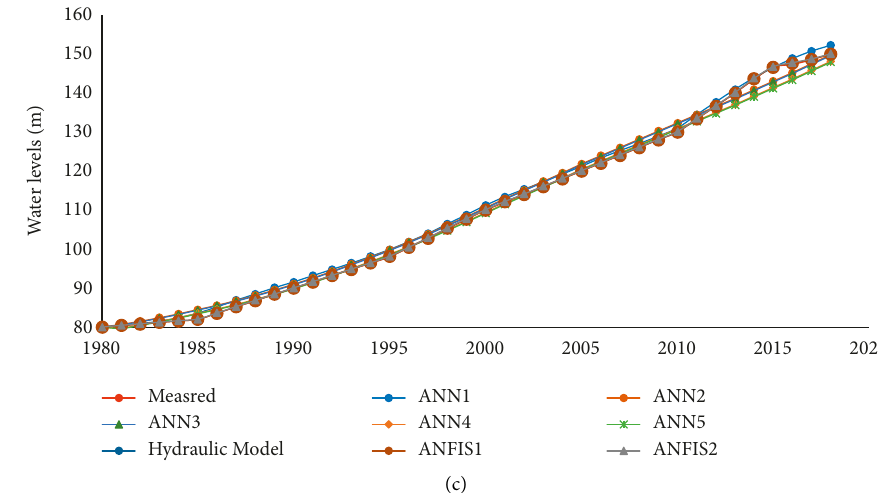
Figure 9: Comparison of the ANN, ANFIS, and hydraulic models. (a) Values of NSE. (b) Predicted versus recorded groundwater depths. (c) Comparison between measured and simulated results by various models with respect to